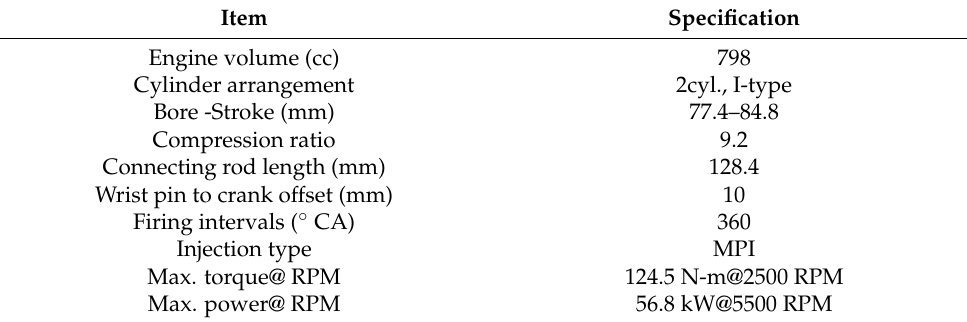
Figure 1. Overall process of the numerical study for non-road MPI Turbo SI engine. Table 1. Engine specifications.